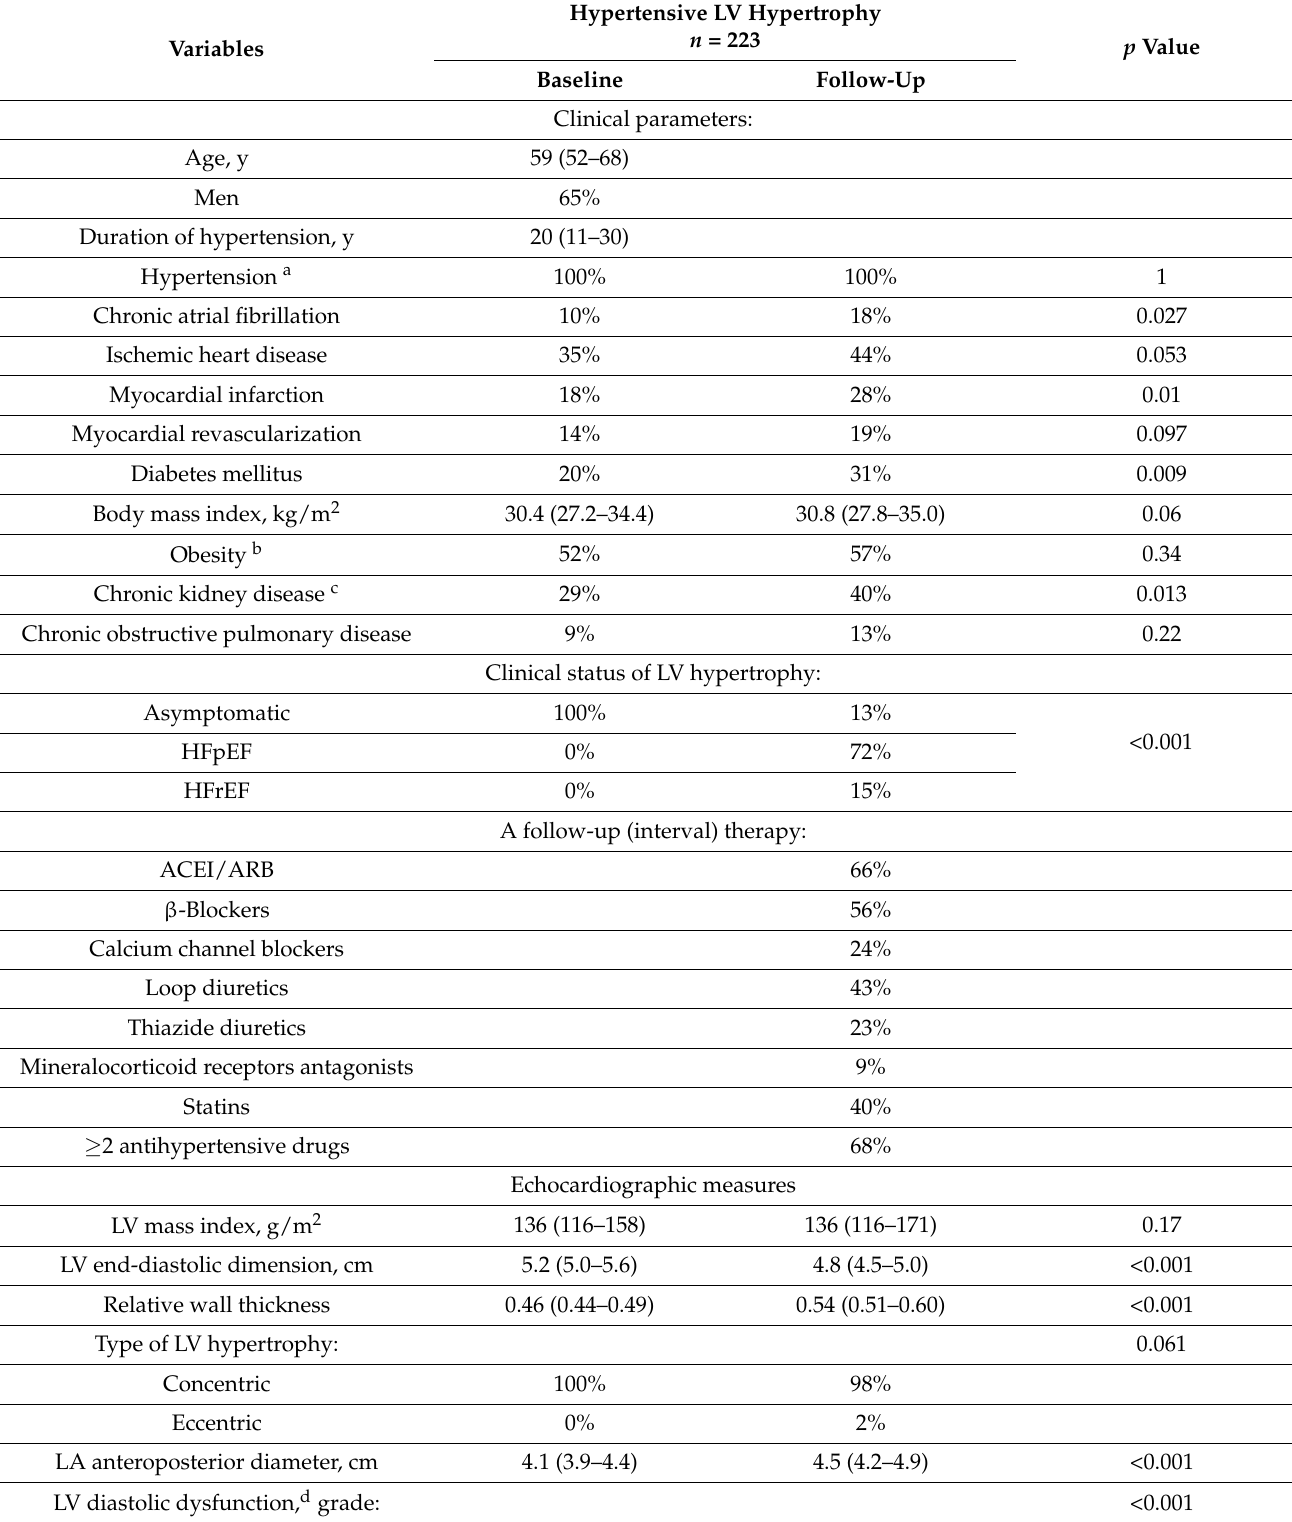
Table 1. Clinical and echocardiographic characteristics in patients with hypertensive concentric LV hypertrophy during the